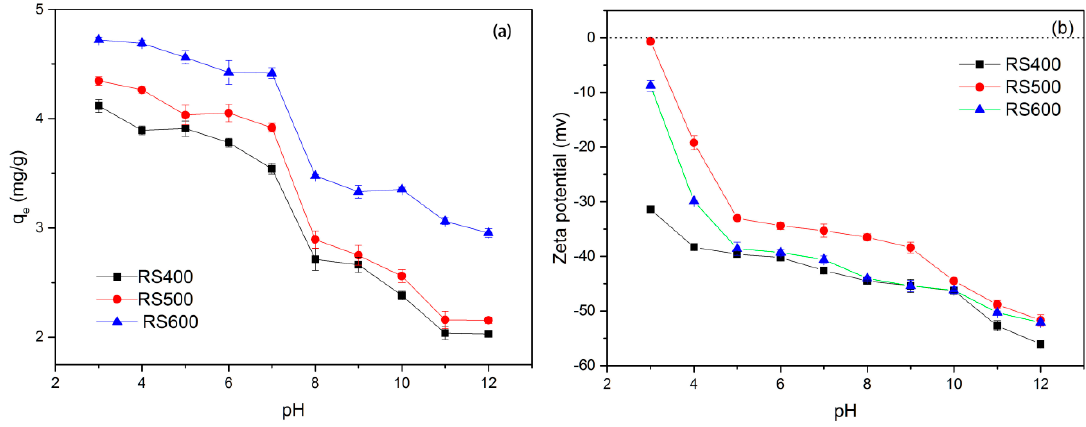
Figure 4. ( a ) Effects of solution pH on E2 by RS400, RS500 and RS600; ( b ) Zeta potential of BCs at different pH. (initial concentration = 1 mg L − 1 ; biochar dose = 0.01 g; temperature = 301 K).